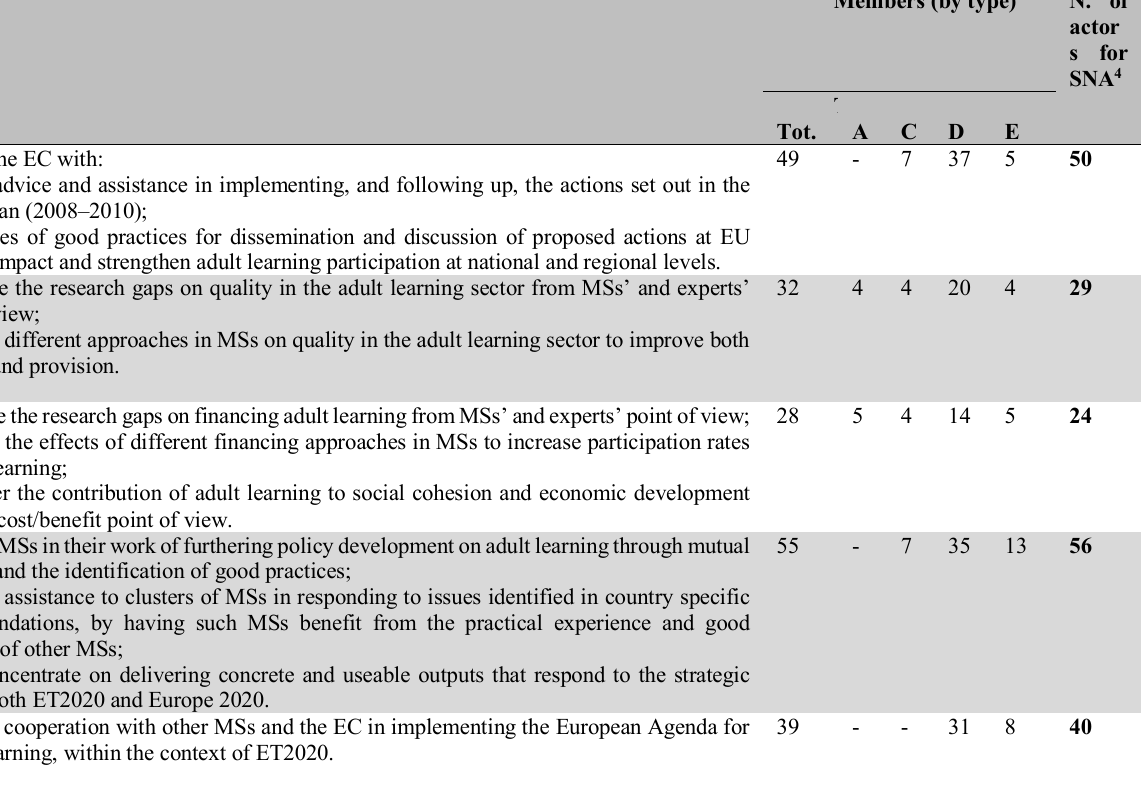
Table 1 – Coordinated working groups/networks in the adult education policy